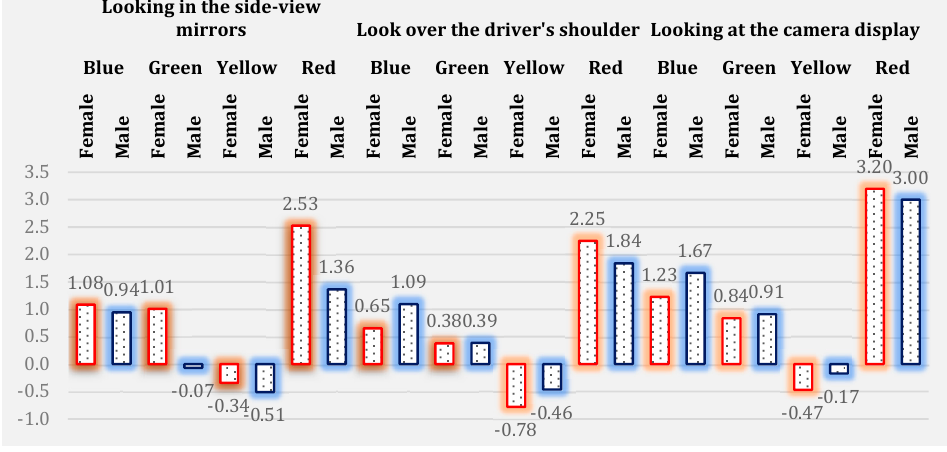
Figure 8. Mean error of estimation of the distance to the object for all conditions and all colors, observed by gender.